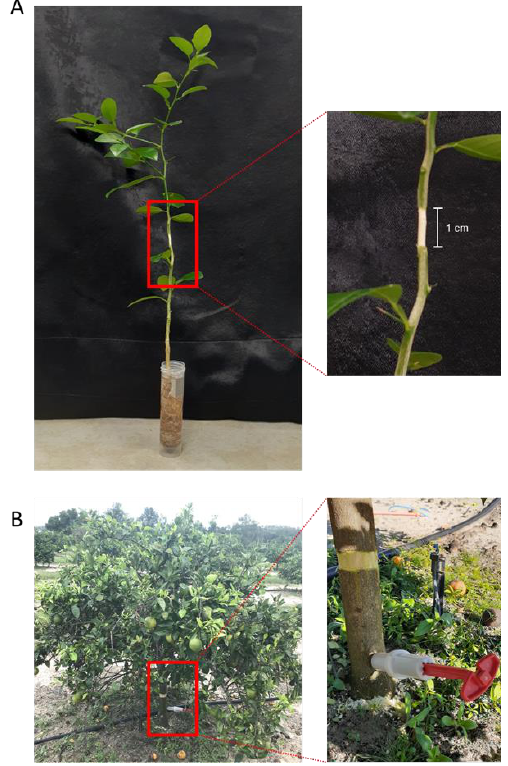
Figure 4. Root drench and trunk injection of oxytetracycline. Application of oxytetracycline solution (200 µg mL −1 ) to girdled ( A ) Mexican lime ( Citrus aurantifolia ) seedlings using root drenching in the laboratory. Trunk injection of oxytetracycline (255 mg per tree) into 5-year-old girdled ( B ) Hamlin trees in the field.